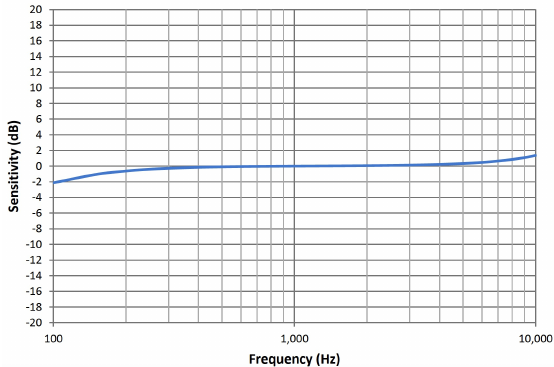
Figure 4. Typical free field frequency response of the SiSonic microphone normalized to 1 kHz